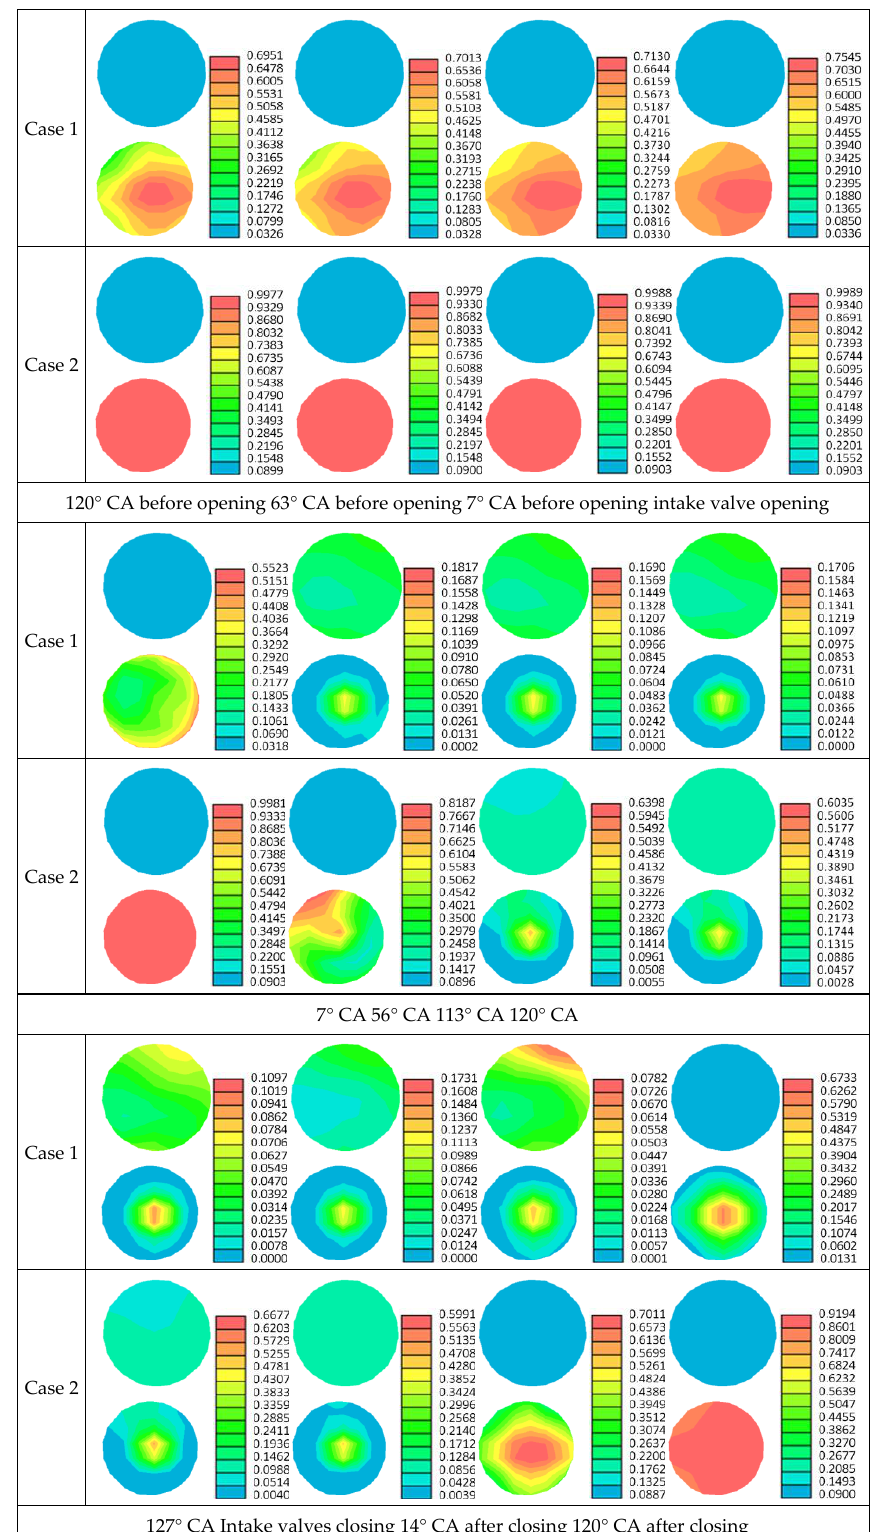
Figure 10. The distribution contour of the CO 2 mass fraction at the outlets of the intake ports of cylinder 1 versus the crank angle under different cases.